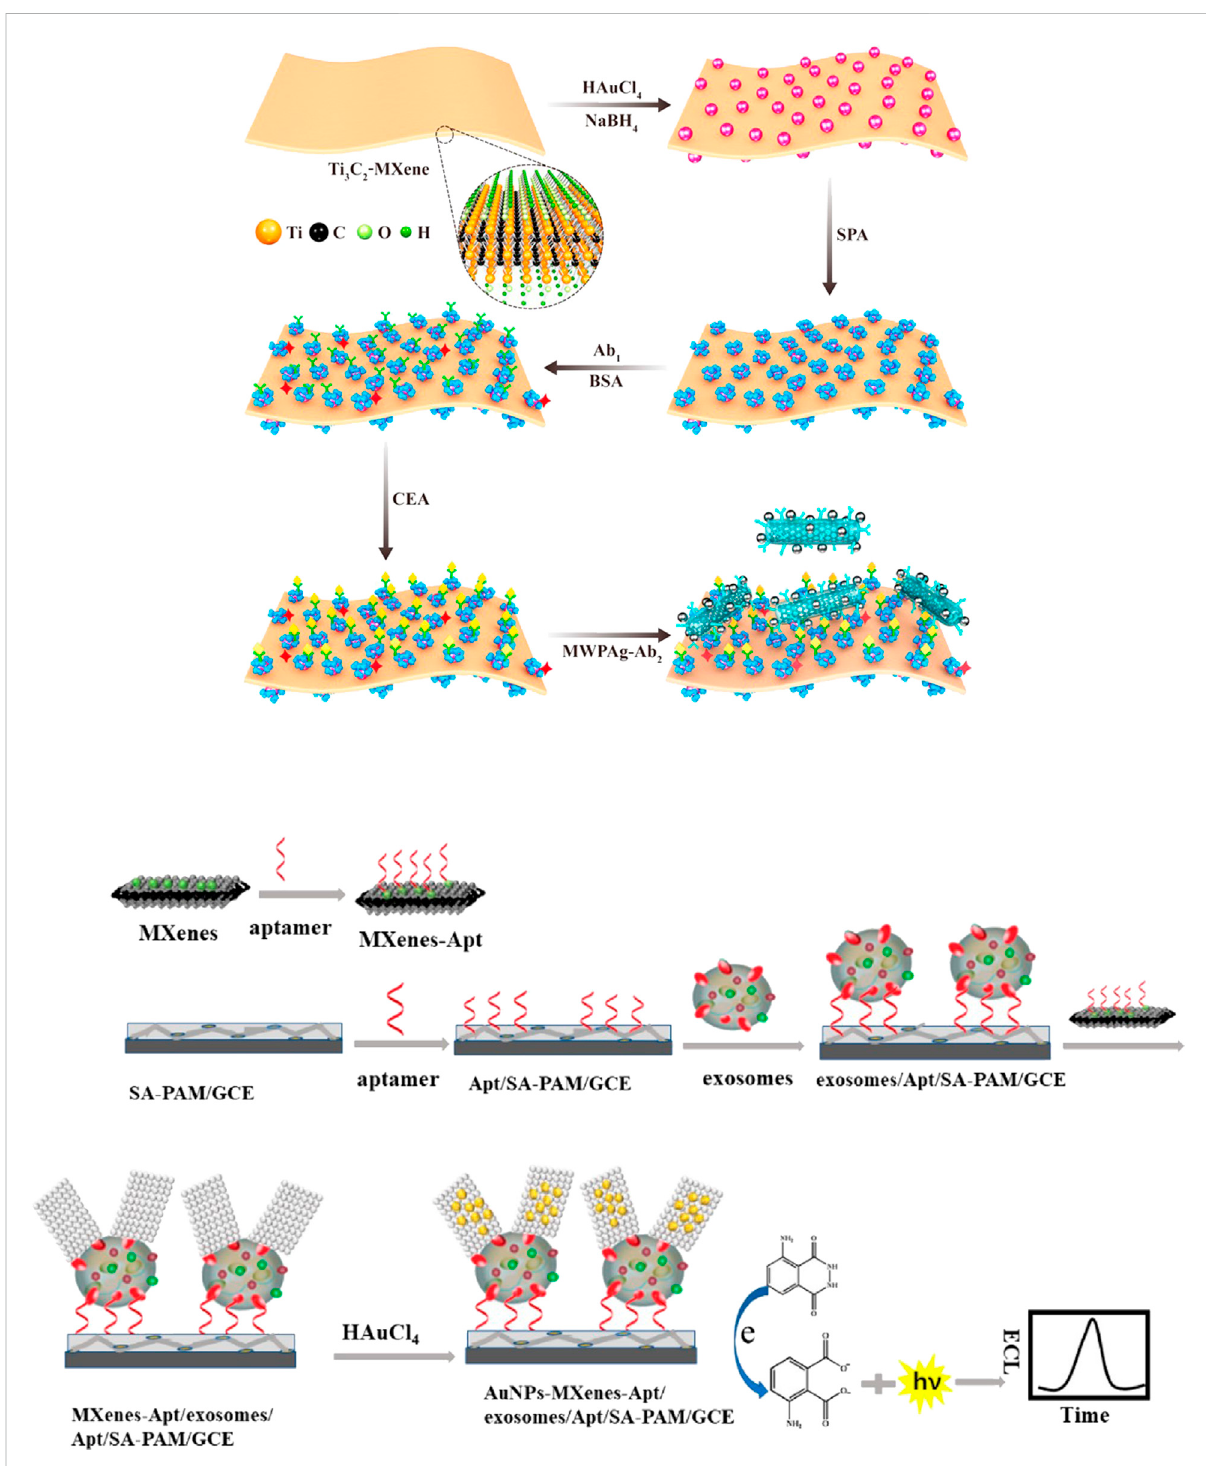
FIGURE 11 (A) Schematic of surface plasmon resonance (SPR) biosensors for detecting CEA, Reproduced with permission from Wu Q. et al. (2019), ©Elsevier. (B) Principle of the electrochemiluminescence (ECL) biosensor for detecting exosomes based on in-situ formation of AuNPs decorated Ti 3 C 2 MXenes nanoprobes, Reproduced with permission from Zhang et al. (2020), ©American Chemical